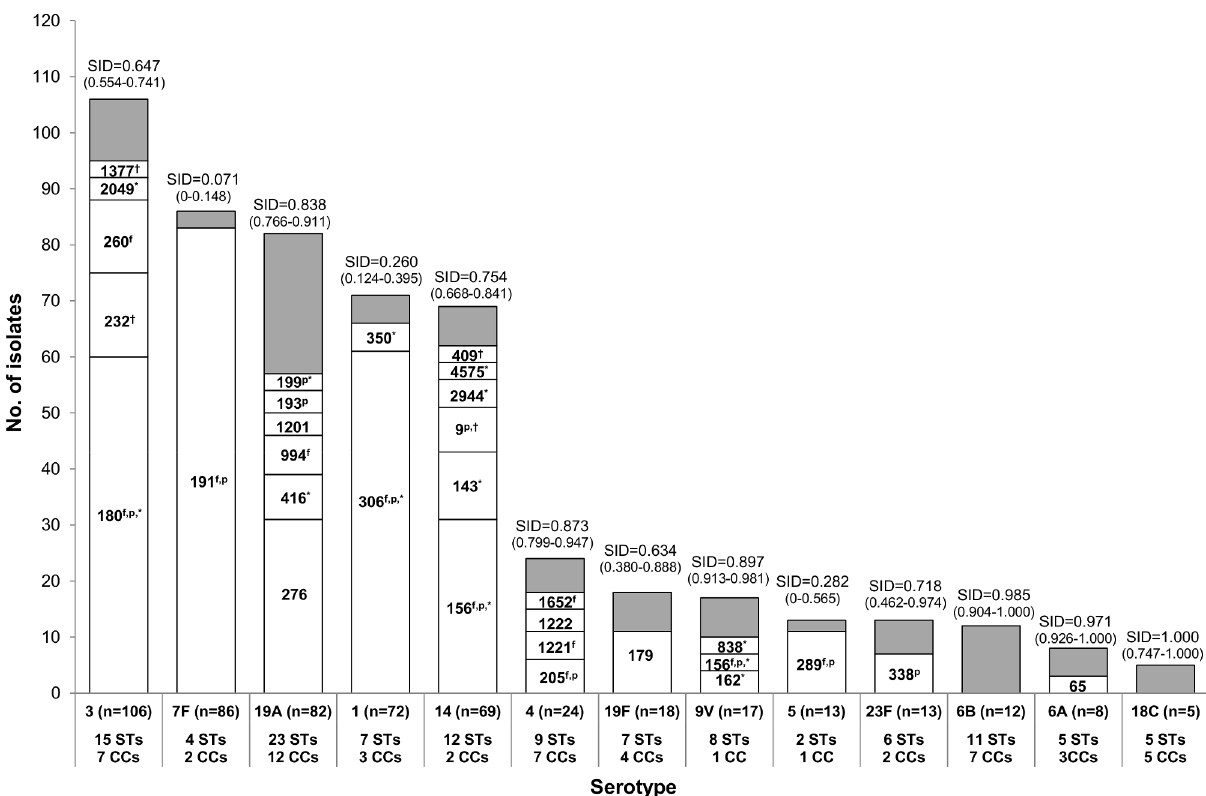
Fig 1. Distribution of STs according to serotype of the isolates causing adult IPD in 2008 – 2011 and expressing serotypes included in the conjugate vaccines. The STs that were considered by goeBURST as founders of a CC are indicated by “ f ” . The STs that matched the STs of PMEN clones are indicated by “ p ” . Marked either with “ * ” or “ † ” are STs belonging to the same CC in each serotype. The respective SID values are indicated on top of the bars and in parenthesis are the respective confidence intervals. In grey are represented the isolates included in STs with < 3 isolates. These were: serotype 4 – ST801 (n = 2) and STs 244, 246, 259 and 1866 (n = 1, each); serotype 6B